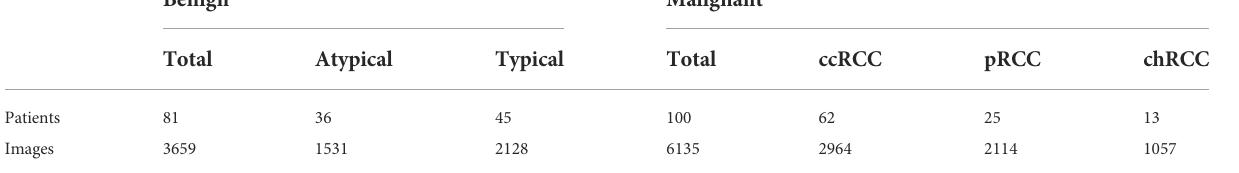
TABLE 2 Number distribution of patients and images among histologic